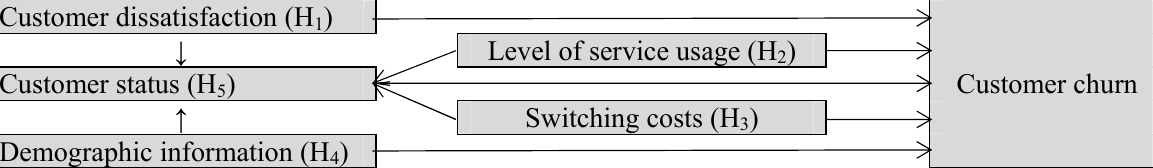
Fig. 2. The framework of the proposed